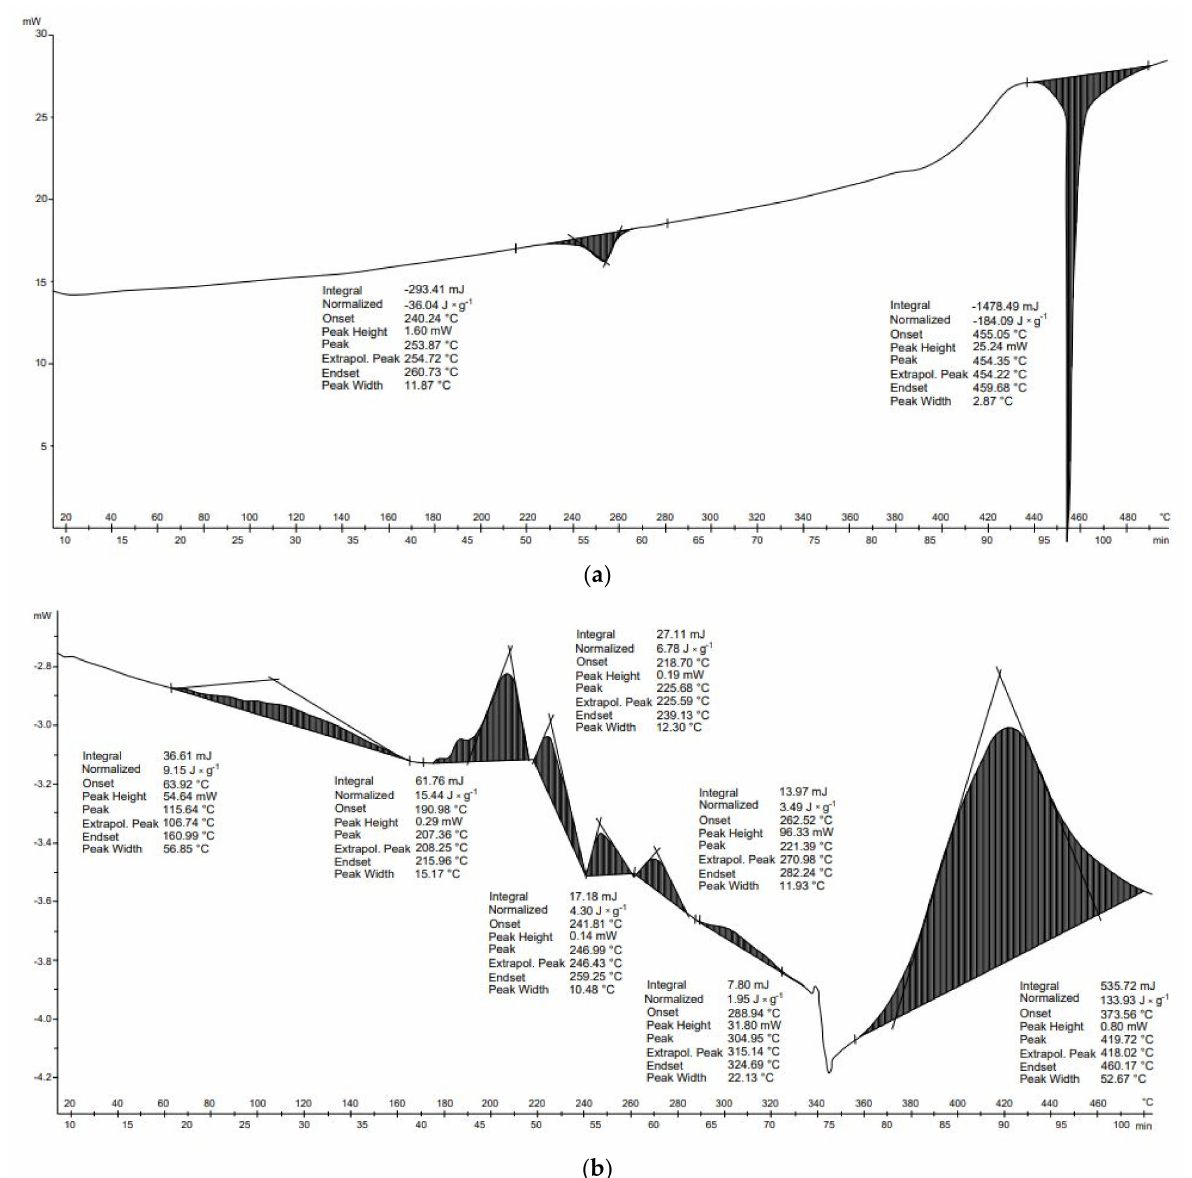
Figure 8. Characteristics of the DSC of plastic waste: ( a ) PET; ( b )